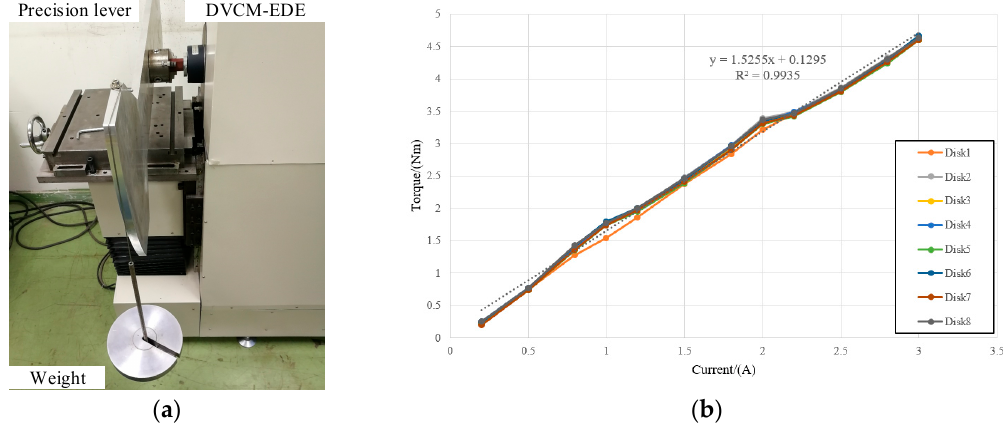
Figure 15. Static experiments with the prototype: ( a ) Lever weight measurement; ( b ) Torque current curve.